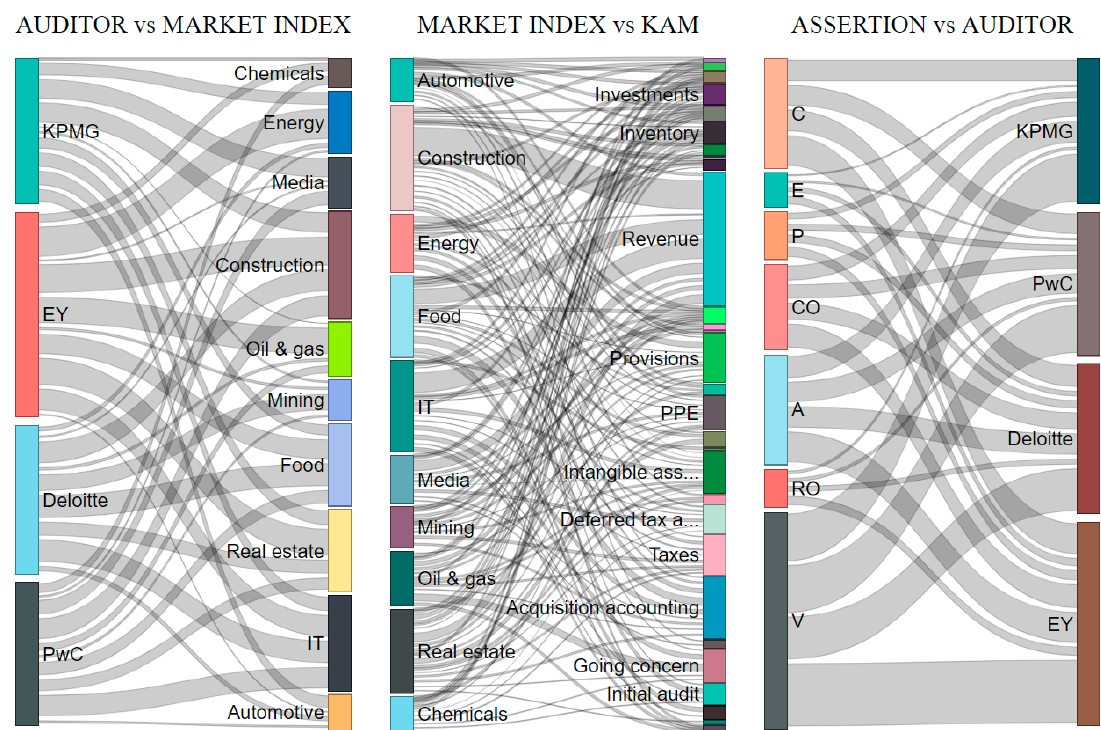
Figure 7. Relationships between auditors, KAMs, assertions, and WIGs—for Big 4 auditing firms. Source: own elaboration based on analyzed data.